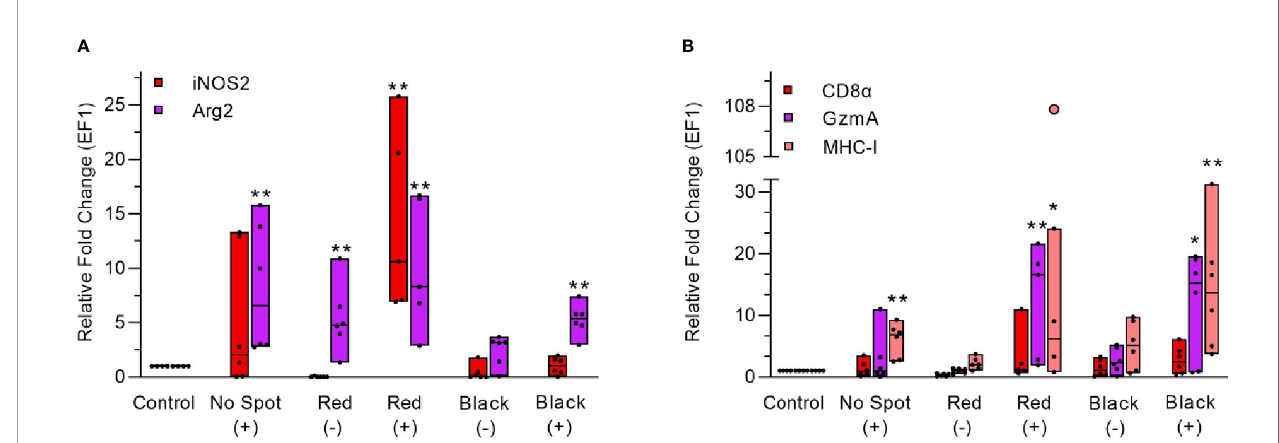
FIGURE 11 | Gene expression analysis during red and black focal changes in PRV infected (+) and uninfected (-) fi sh groups. (A) Relative fold change (median line) for each fi sh group is shown for iNOS2 and Arg2 (left Y-axis). (B) Relative fold change (median line) for each fi sh group is shown for CD8 a , GzmA and MHC-I. Pink dot showing outlier value in the respective group. Each dot within boxes represents individual fi sh in the group. Gene expression relative to the control group (uninfected and unaffected) fi sh was normalized against EF1ab. * indicates signi fi cantly different from the control group (* p < 0.05, **p < 0.01